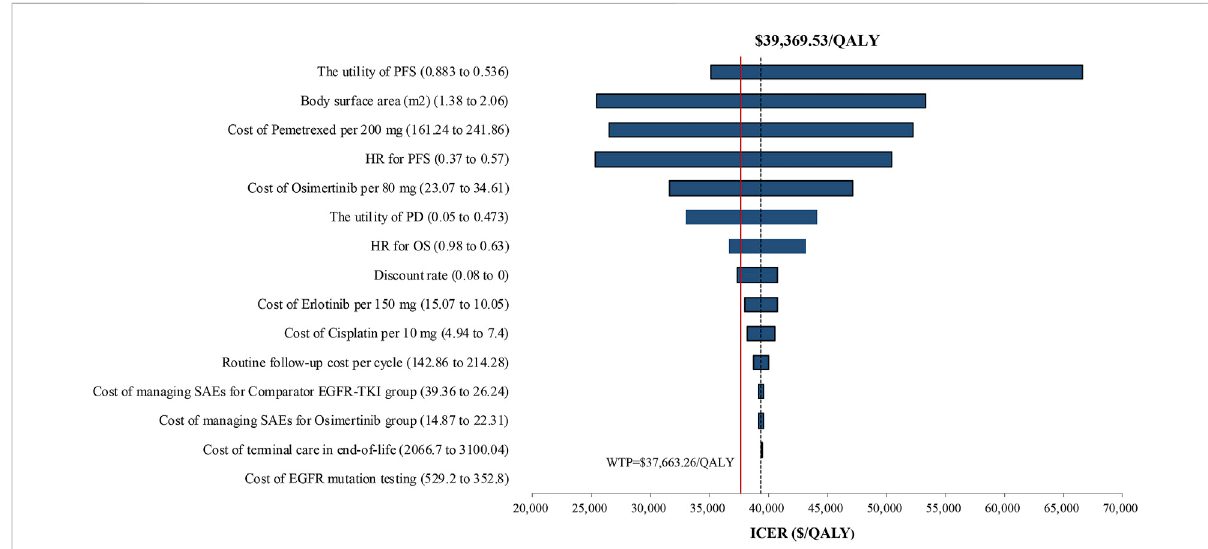
FIGURE 3 Tornado diagram of one-way sensitivity analysis. It summarized the results of the one-way sensitivity analysis, which listed in fl uential parametersin a descending order according to their effect on the ICER over the variation of each parameter value. Abbreviations: ICER, incremental cost-effectiveness ratio; PFS, progression-free survival; PD, progressive disease; SAEs, serious adverse events; EGFR-TKI, epidermal growth factor receptor – tyrosine kinase inhibitor; HR, hazard